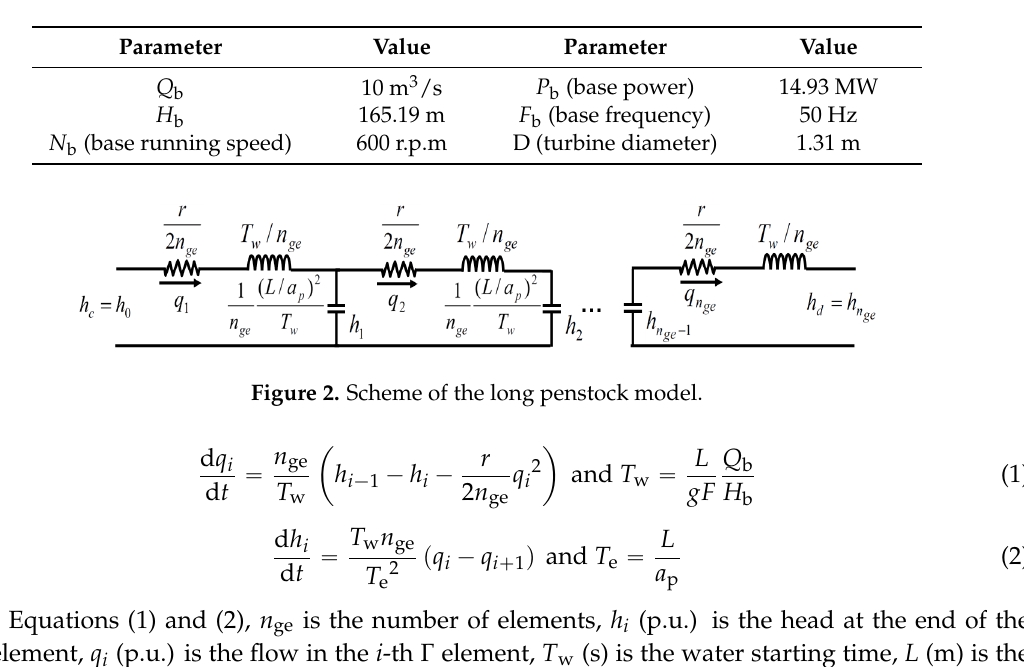
Figure 3. Scheme of the short penstock model.